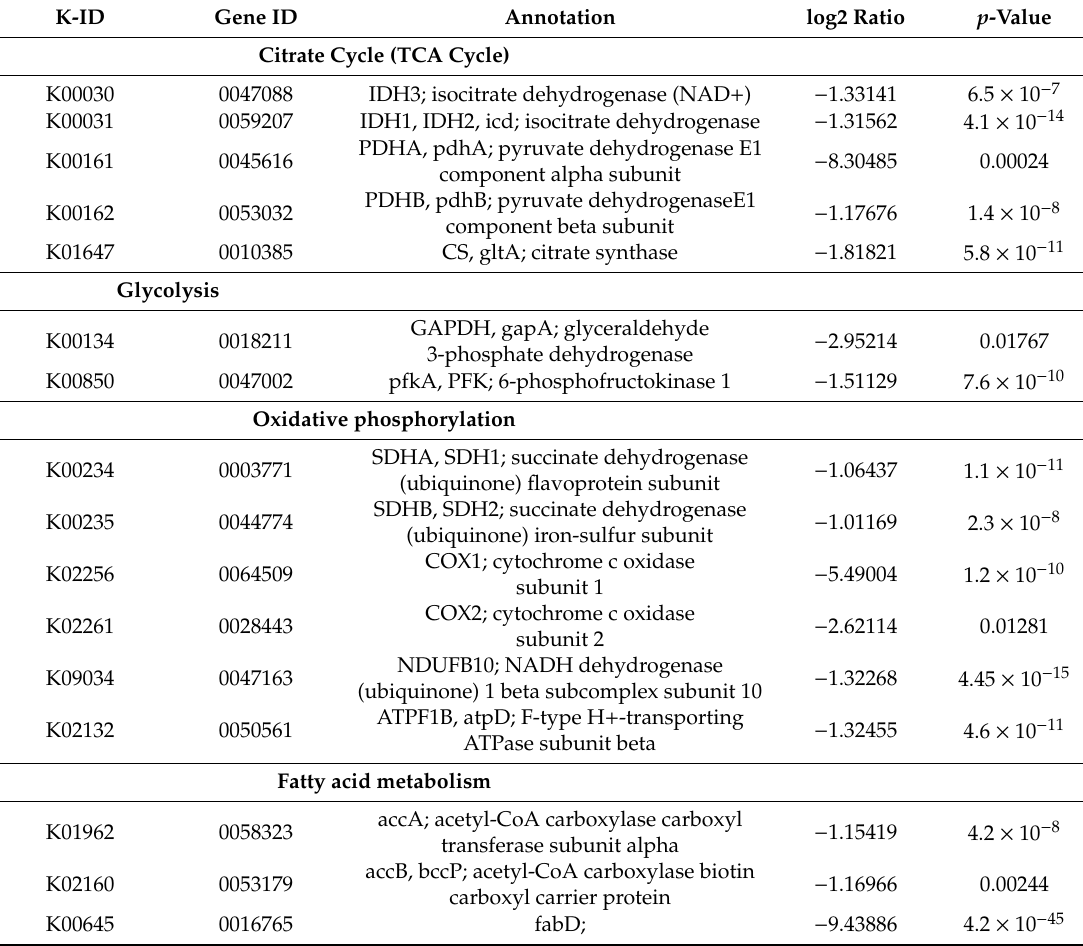
Table 4. Annotation and expression changes of unigenes related to the Tricarboxylic acid (TCA) cycle, glycolysis, oxidative phosphorylation, and fatty acid